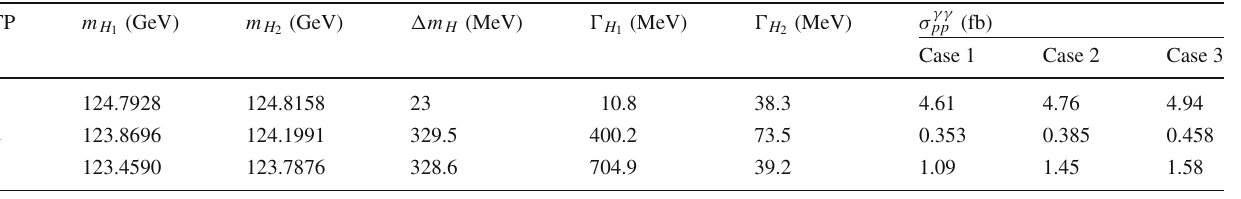
Table 5 Values of the input parameters for the three TPs considered. All dimensionful parameters are in units of